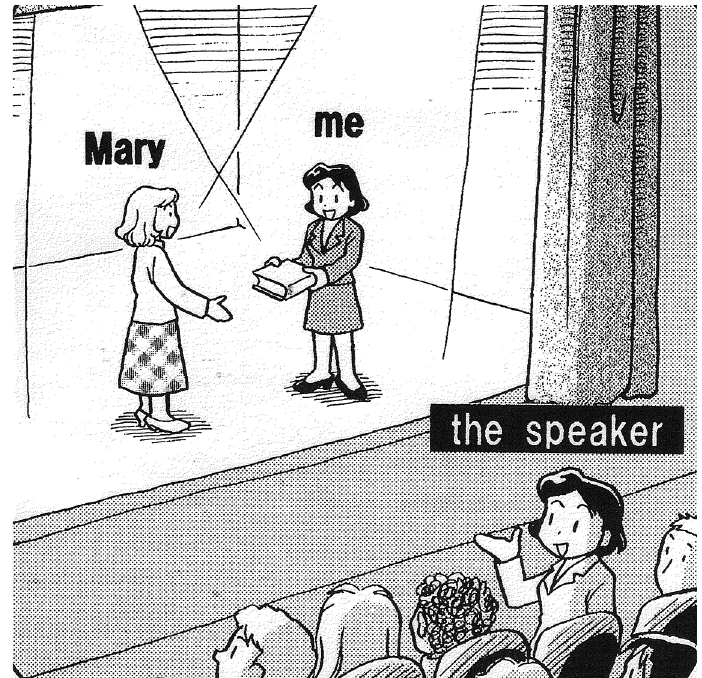
Figure 3. Mary gave me this book [English] (Ide 2006: 223).